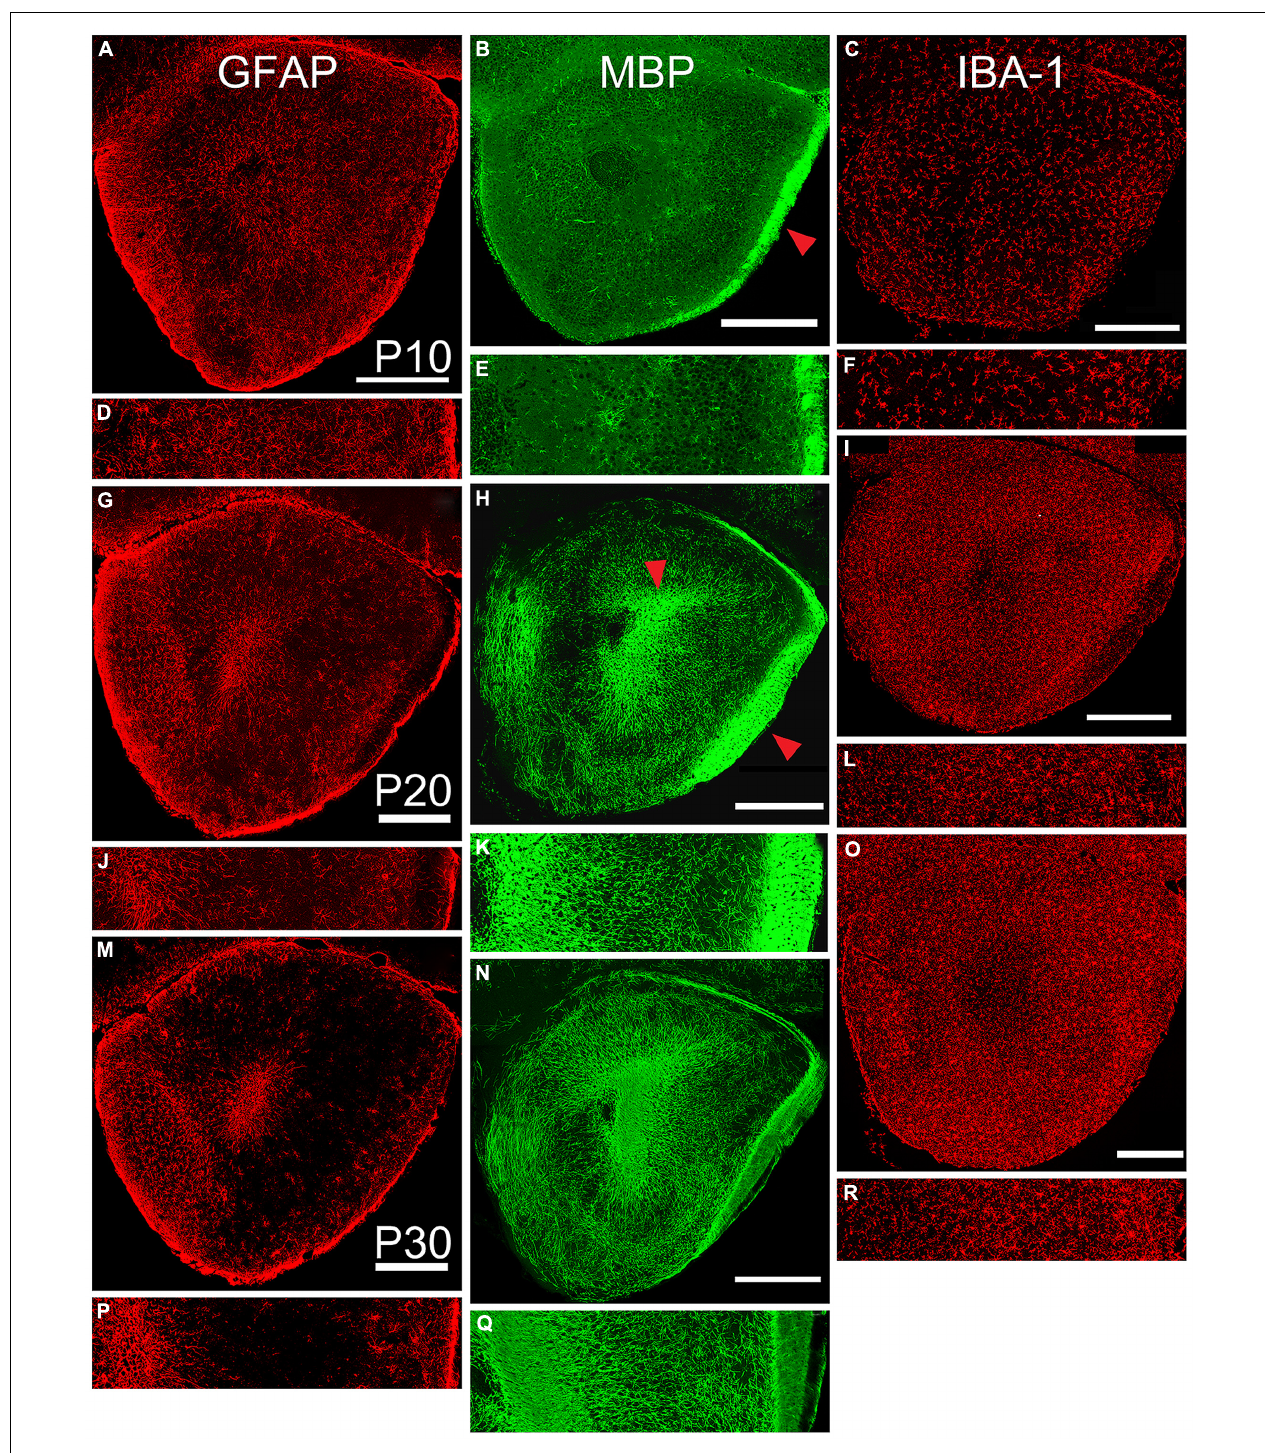
P20 ( G,J; H,K, and I,L ), and P30 ( M,P ; NQ ; and O,R ). Scale bars on low-power images = 500 μ m. While the density of staining for astrocytes exhibited an age-related decrease, the other two markers increased in expression during the age range examined. Red arrow in Panel B = LOT, Panel H = LOT and